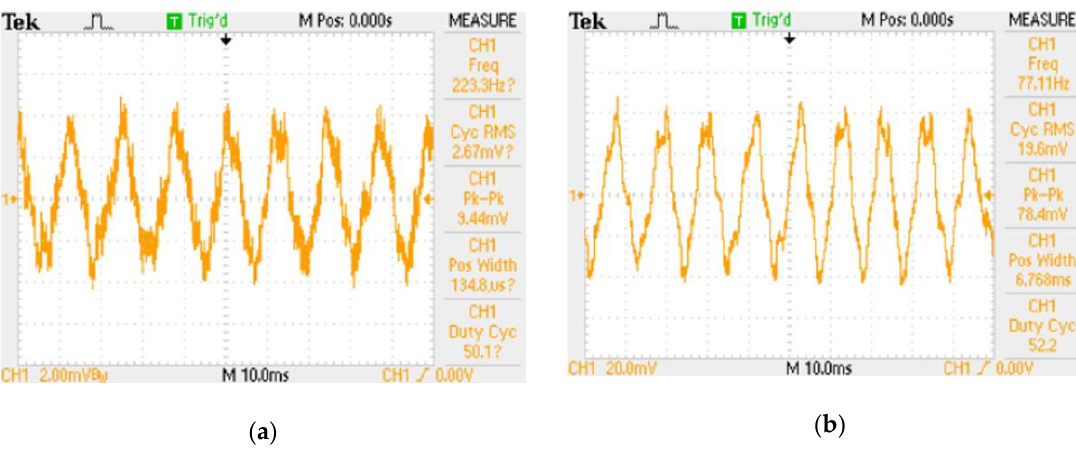
Figure 5. Waveforms at output of flow transducer: ( a ) Signal straight from output of flow transducer; vertical sensitivity in oscilloscope channel 2 mV/division; ( b ) Signal after amplification by active differential probe; vertical sensitivity in oscilloscope channel 20 mV/division.